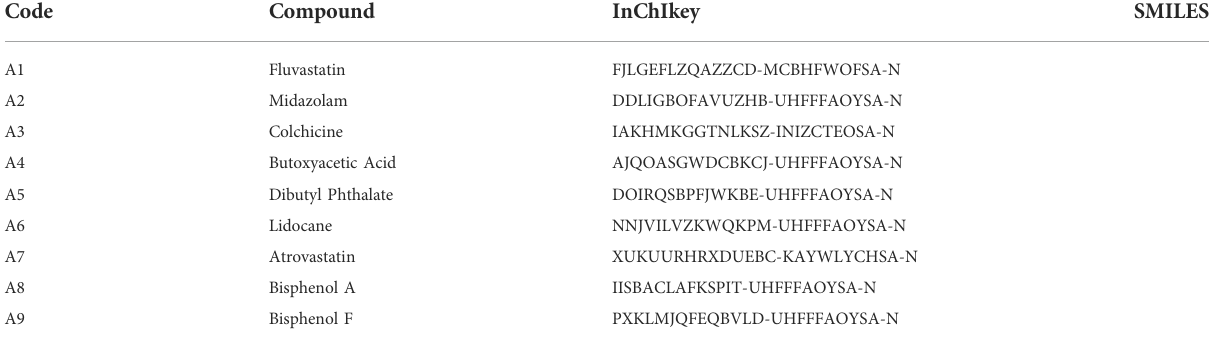
TABLE 4 An exemplar compound fi le of nine compounds containing all compound InChI keys. Codes are arbitrarily generated for the compounds. The SMILES header is present but has no entries beneath it; this will not impede the progression of the work fl ow as only InChI keys are required for automated data